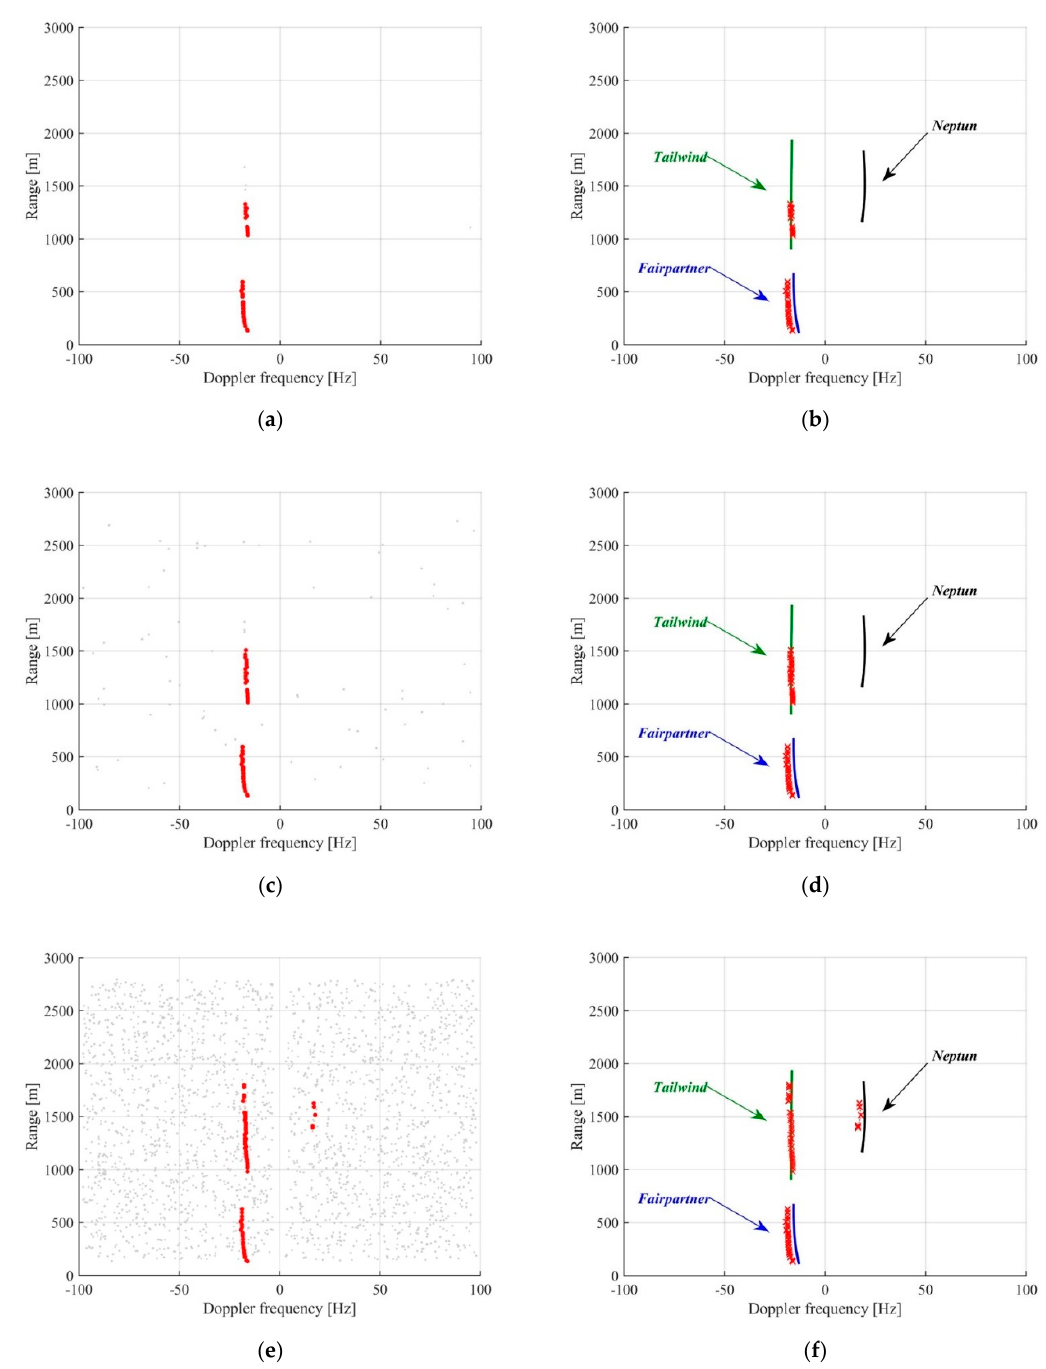
Figure 7. Marghera port detection results - plot lists over the different scans for detector and plot extractor (DPE) operating with P fa = 10 − 4 ( a ), 10 − 3 ( c ), and 10 − 2 ( e ); comparison between the resulting tracklets and the automatic identification system (AIS) ground truth (full lines) for P fa = 10 − 4 ( b ), 10 − 3 ( d ) and 10 − 2 ( f